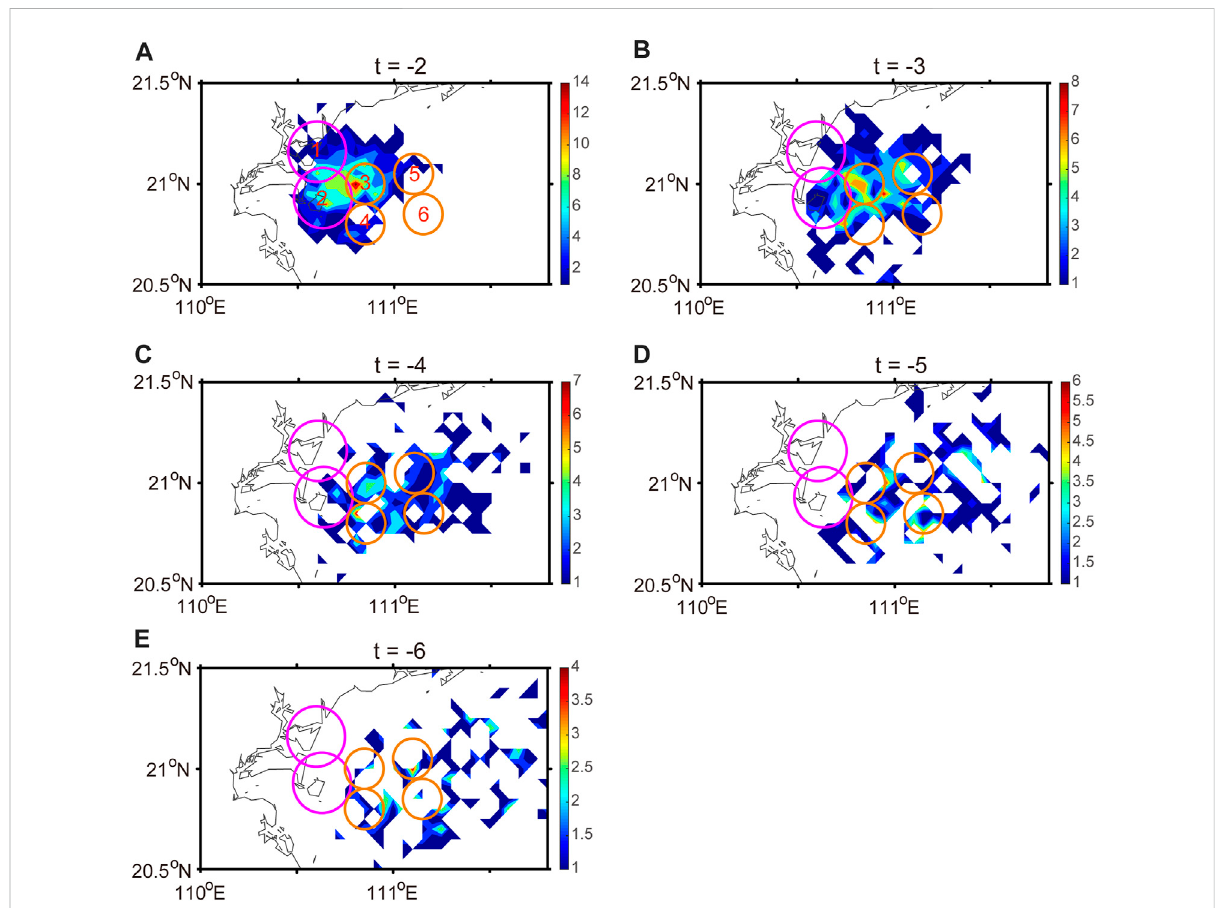
FIGURE 8 Same asFigure 7,but forZhanjiangharbor. Numbers 1 – 6arestation locations: 1)and2)arevisibilitylidars,3)to 6) arebuoys. Pinkcircles arethe effective radius of the lidar (15 km), smaller brown circles are those for the buoys (10 km).